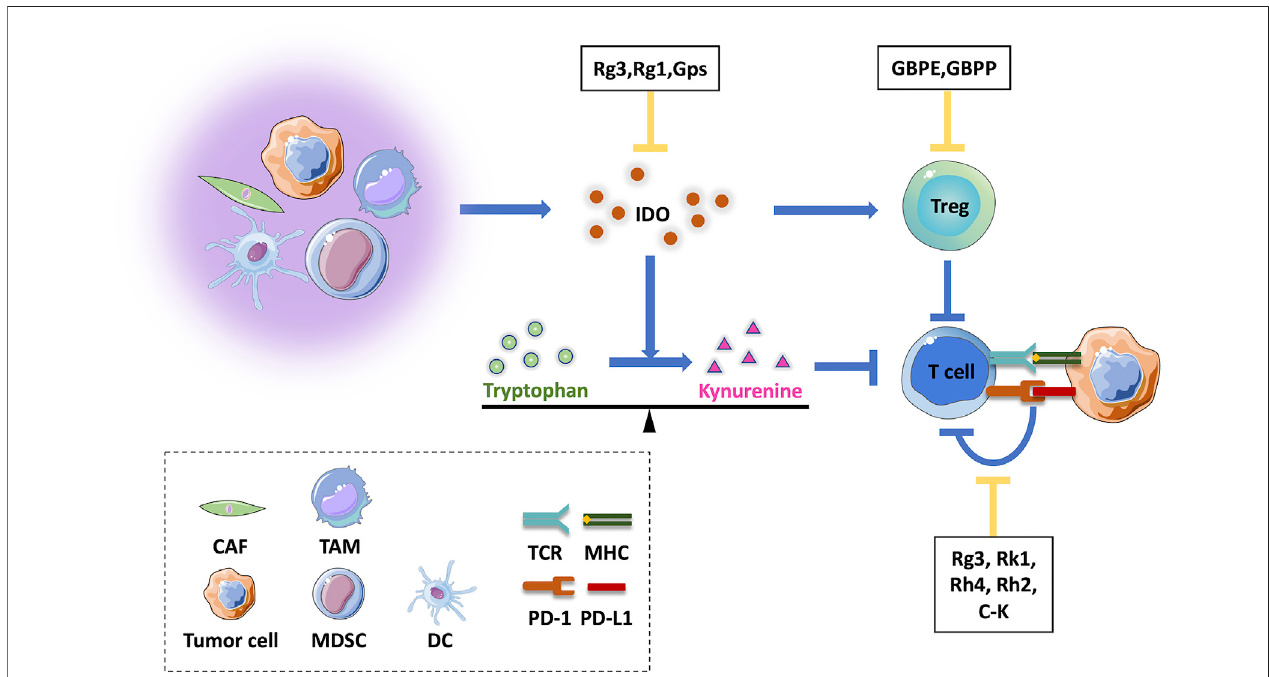
FIGURE2| Effectsofactiveingredientsofginsengonacquiredimmuneresponsesinthetumormicroenvironment.Avarietyofcellsinthetumormicroenvironment may inhibit T cell functions, either through direct modulation of the IDO molecular switch or indirect effects that maintain immunosuppressive Treg cells within the tumor microenvironment. Tumor cells inhibit T cell functions through the PD-1/PD-L1 axis, resulting in immune escape. Active ingredients of ginseng act to inhibit these processes. CAF, cancer-associated fi broblast; TAM, tumor-associated macrophage; MDSC, myeloid-derived suppressor cell; DC, dendritic cell; GBPE, ginseng berry polysaccharide extract; GBPP, ginseng berry polysaccharide portion; IDO, indoleamine